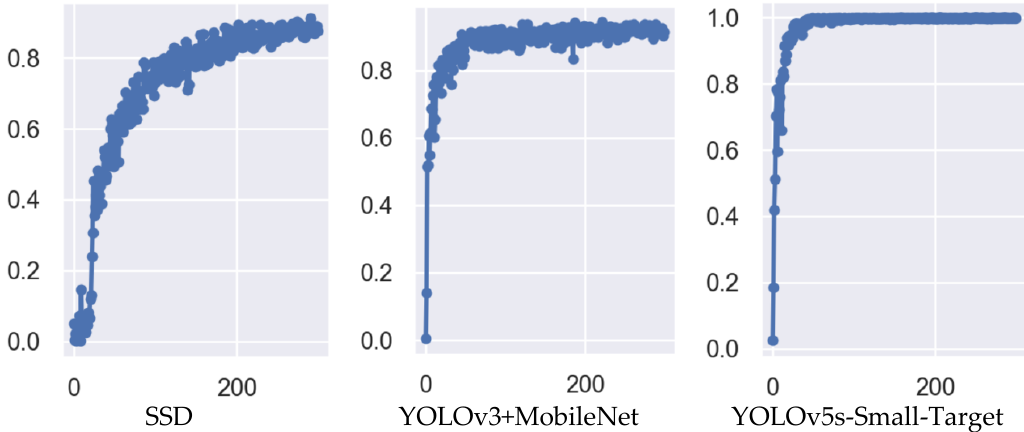
Figure 20. Comparison of defect detection Recall of different detection algorithms.